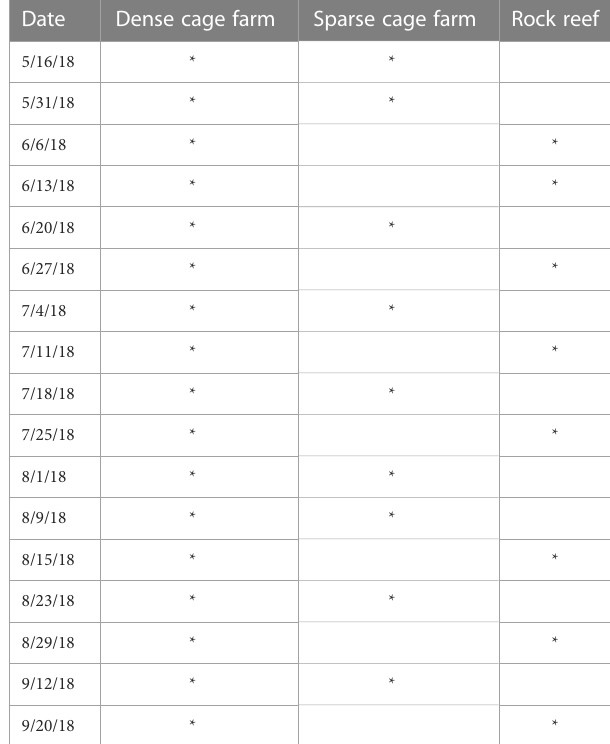
TABLE 1 Dates of video collection at three habitats in